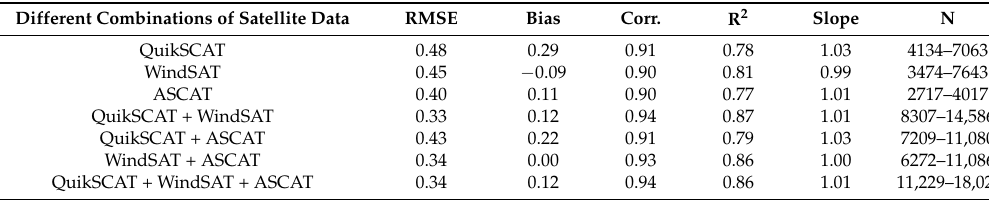
Table 4. Statistics of the comparison between buoy-derived MWS and satellite-derived MWS (m/s) at a height of 100 m above sea level. Different Combinations of Satellite Data RMSE Bias Corr. R 2